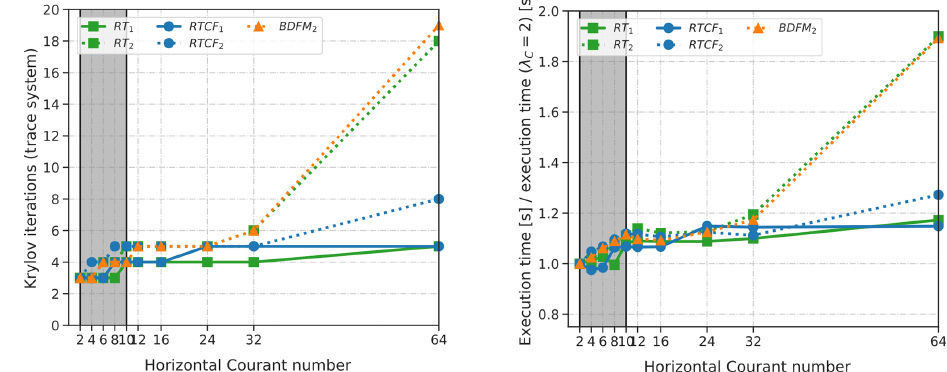
Figure 9. Courant number parameter test run on a fully loaded compute node. Both figures display the hybridized solver for each discretiza- tion, described in Table 6. Panel (a) displays to total iteration count (preconditioned GCR) to solve the trace system to a relative tolerance of 10 − 5 . Panel (b) displays the relative work of each solver, which takes into account the time required to forward eliminate and locally recover the velocity and